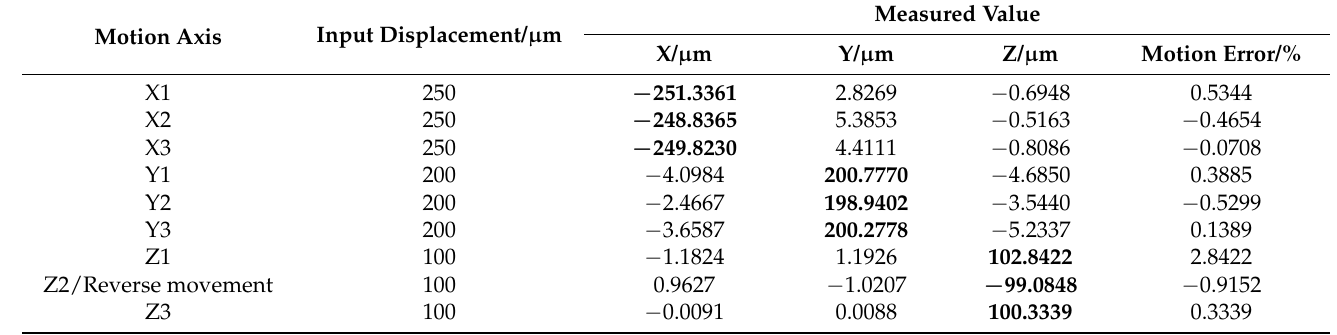
Table 2. Measurement results of three DOF in X, Y, and Z directions. The bold indicates main dis- placements.